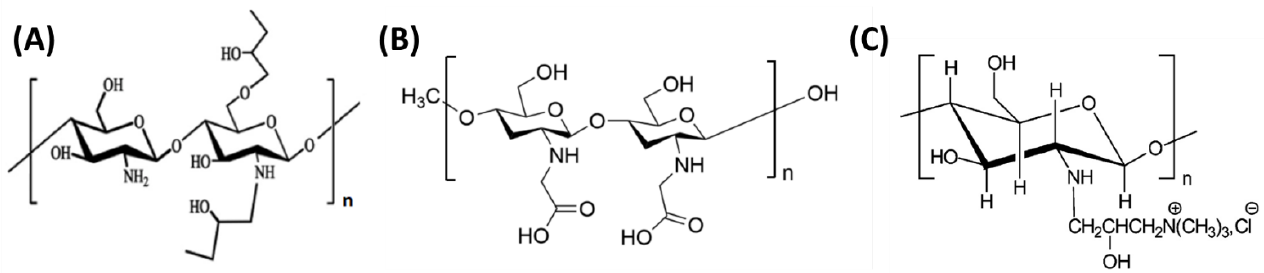
Figure 7. The structural formulas of chitosan derivatives: ( A ) hydroxybutyl chitosan; ( B ) carbox- ymethyl chitosan; and ( C ) quaternary ammonium chitosan.